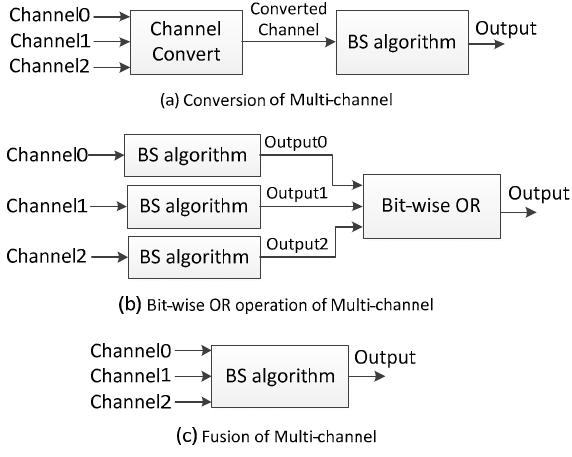
Figure 3. Multi-channel processing in background subtraction.